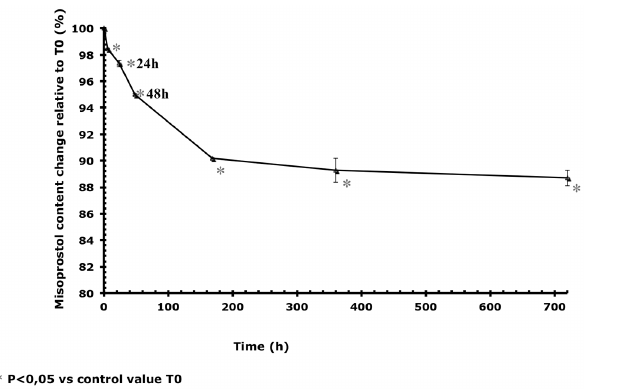
Fig. 6. Changes over time in the misoprostol concentration of tablets stored at 25 ˚ C/60% RH in comparison with T0. The vertical bars represent the 95% confidence interval limits for the measured content